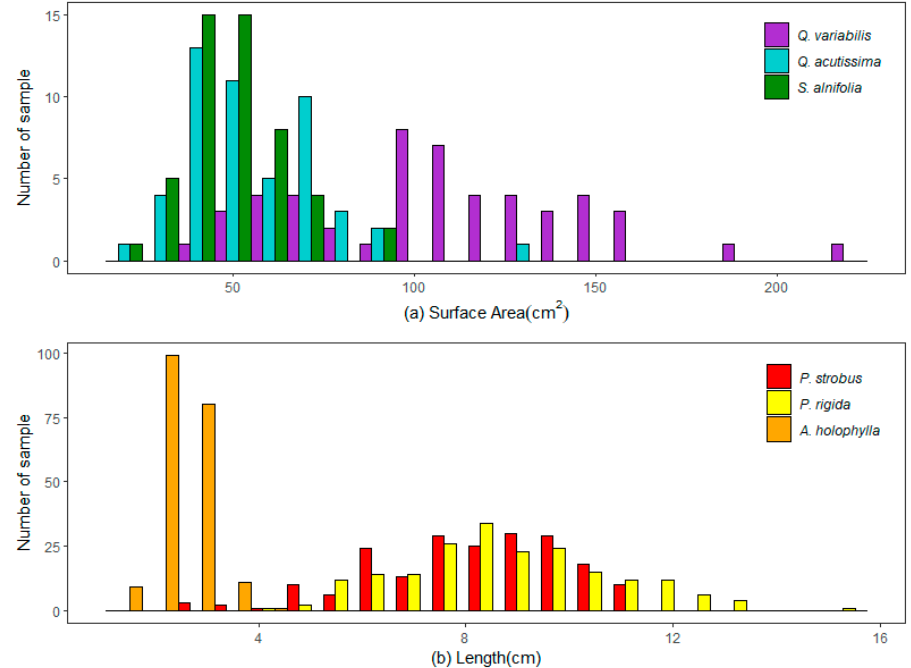
Figure 4. Distribution of ( a ) the surface area of the broadleaf litter, and ( b ) the length of the needle-leaf litter.